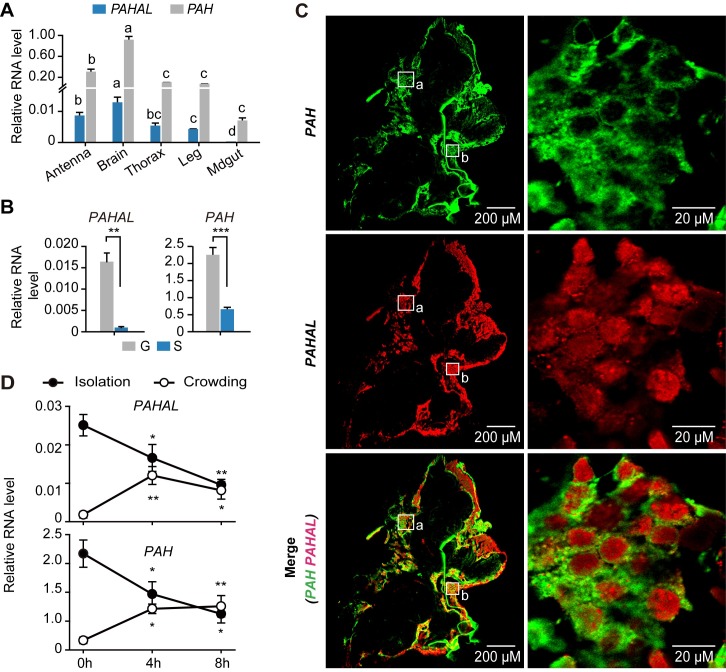
PAHAL expression is positively correlated with the PAH expression in the brain during the behavioural transition of locusts.(A) Tissue expression of PAHAL and PAH. The mRNA level was quantified through qPCR. Means labelled with different letters within each gene are significantly different (P < 0.05). (B) PAHAL and PAH expression in the brains of gregarious (G) and solitarious (S) locusts. (C) Localisation of PAHAL and PAH in the G brains as revealed through double fluorescence in situ hybridization (FISH). Images are shown at 10× (left images) and 63× (right images) magnification. The "a" squares specifically indicate the brain region of the right images in the locust protocerebrum. The brain region of the Fig 5B is indicated by the "b" squares in the locust deutocerebrum. (D) Profiles of the PAHAL and PAH expression in the brain during locust isolation and crowding. Eight biological replicates of eight brains were measured. Asterisks indicate significant differences between each time point and at 0 h (P < 0.05). Student’s t-test: *P < 0.05; **P < 0.01; ***P < 0.001.